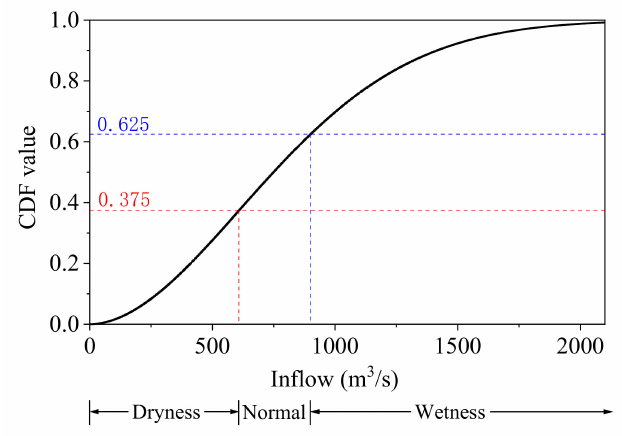
Figure 4. The division of wetness, normal, or